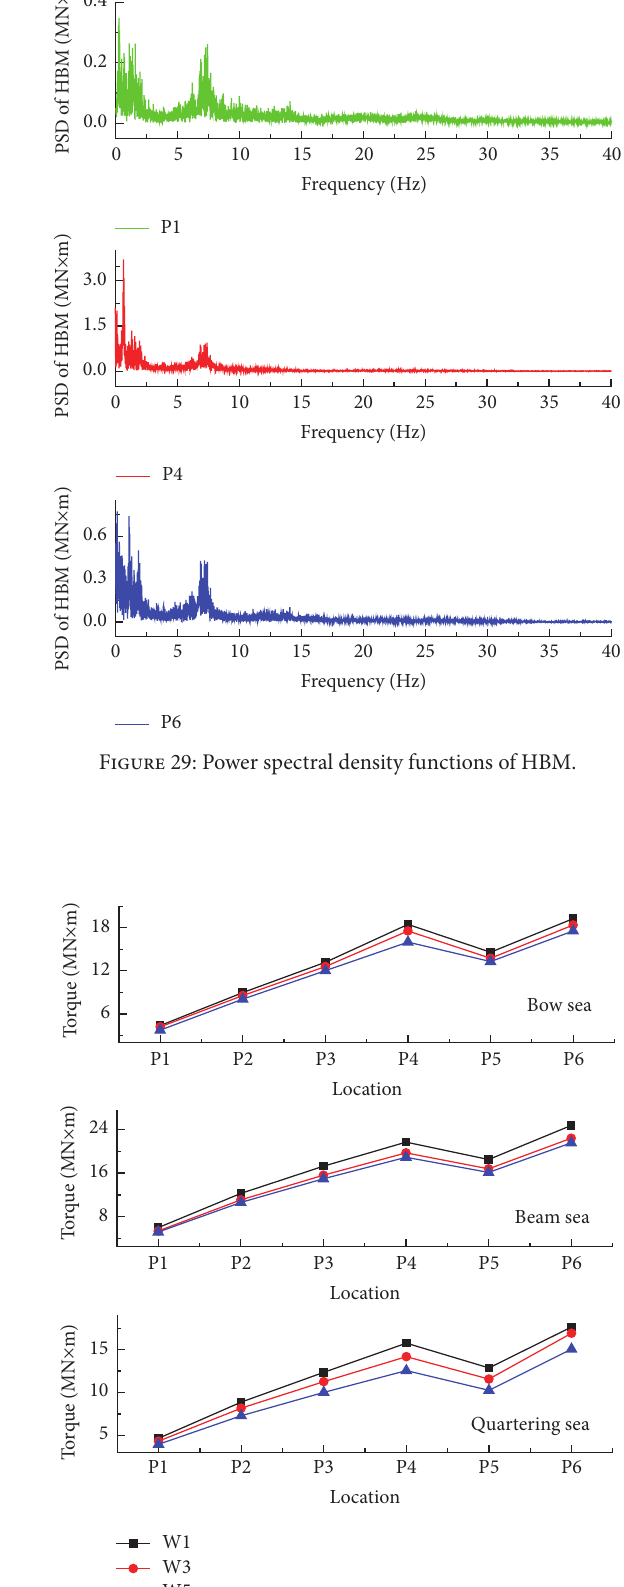
of torque falling at P5 is explained where the sharp increase in torsional stiffness caused by side hull structure alleviates the torsional deformation, and the structure of side hull also takes more torsional load for trimaran, which increases the torque at stern again.